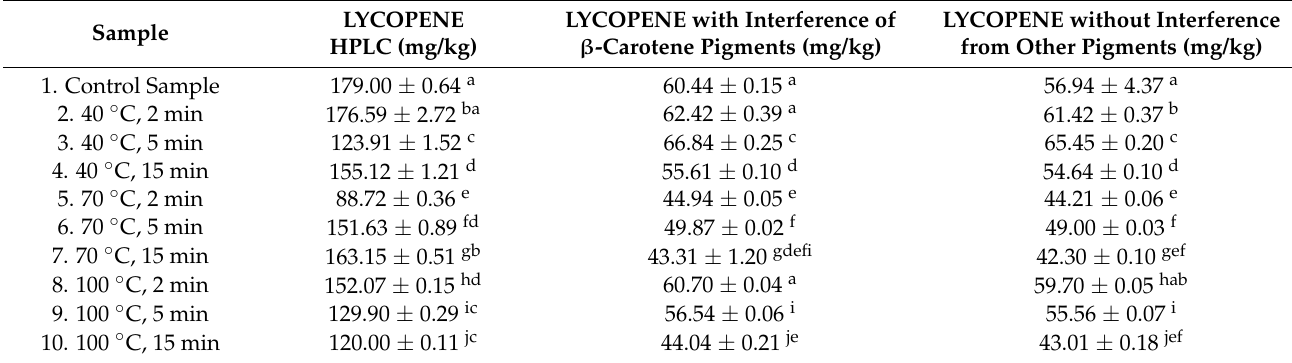
Table 2. Effect of sample heat treatment at 40, 70, 100 ◦ C on the lycopene content of the watermelon determined spectropho- tometrically and by